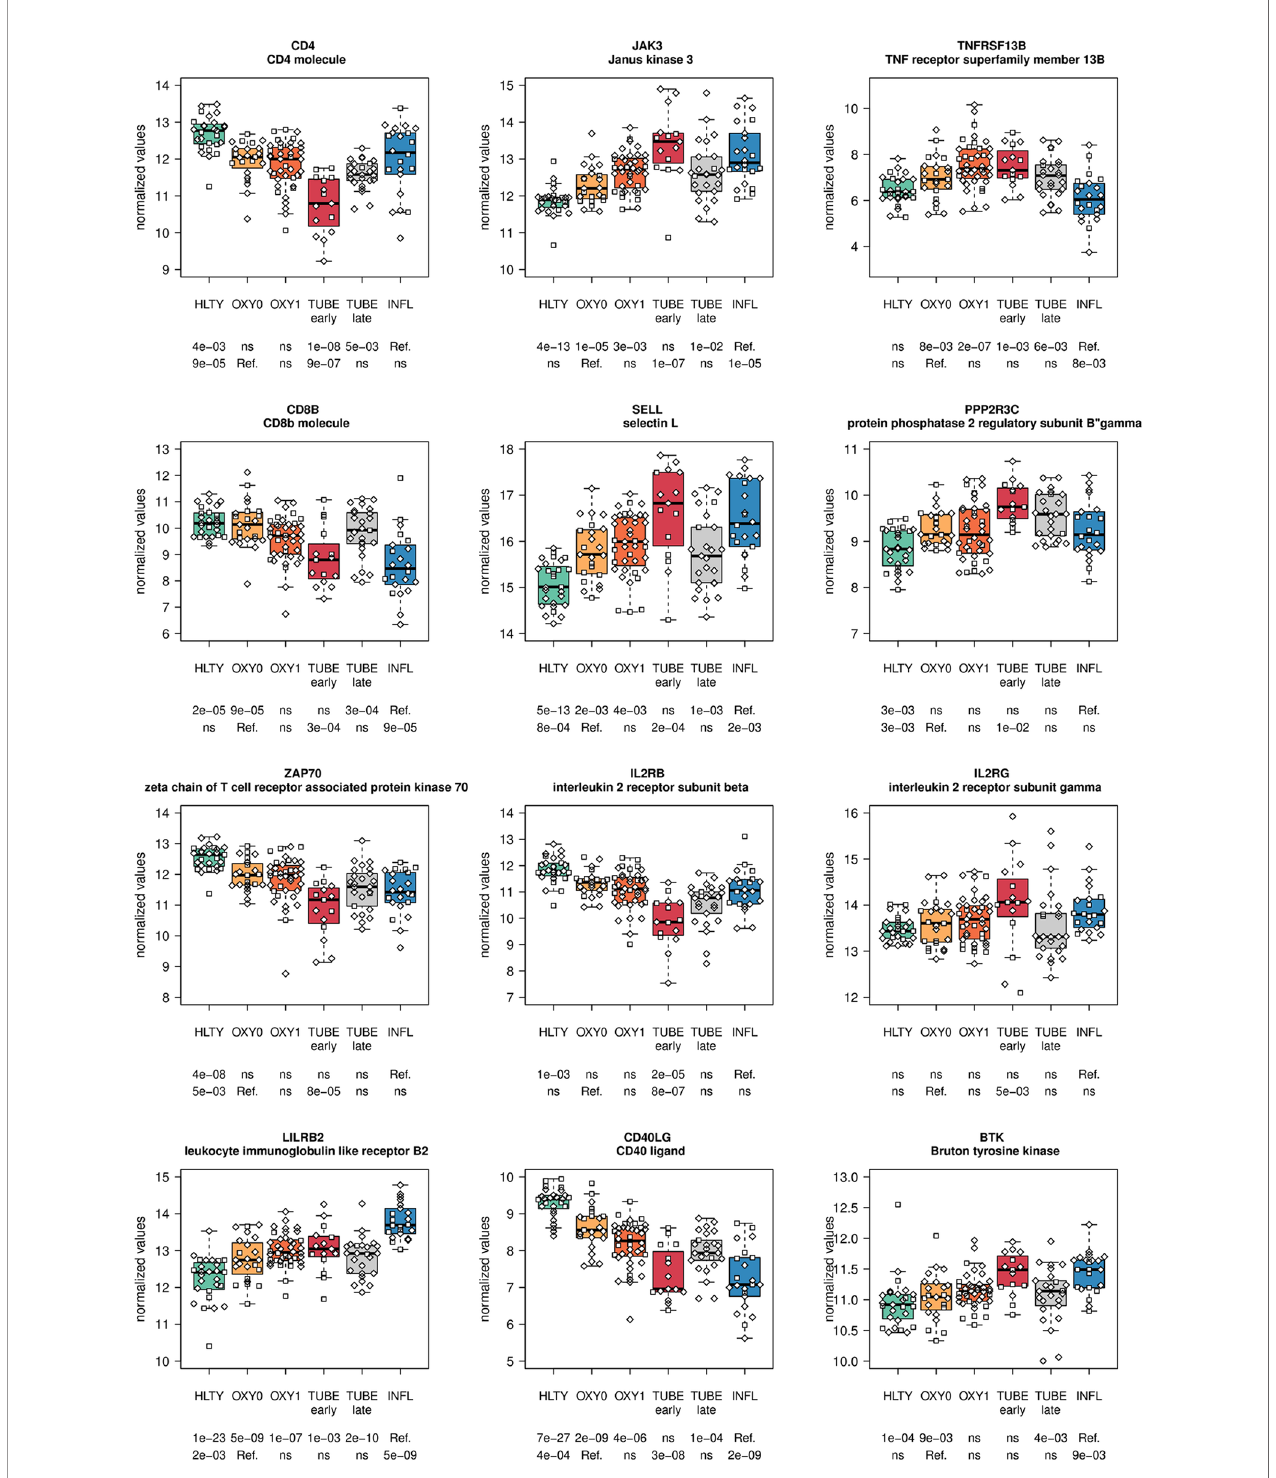
FIGURE 8 | Differentially expressed genes (DEGs) involved in T cells and B cells functions. Expression levels of selected genes involved in T and B cells function and regulation. Groups used for comparisons include SARS-Cov-2 infected patients (no oxygen support [OXY0], oxygen support [OXY1], intubation with sampling within 7 days [TUBE early] or >7 days [TUBE late] after hospital admission), In fl uenza virus [INFL] infected patients and non-infected controls [HLTY]. Adjusted P-values of pairwise comparisons between a reference group (Ref.) and another group are indicated below the x axis. Ref. is taken as [INFL] and [OXY0] on the fi rst and second line,